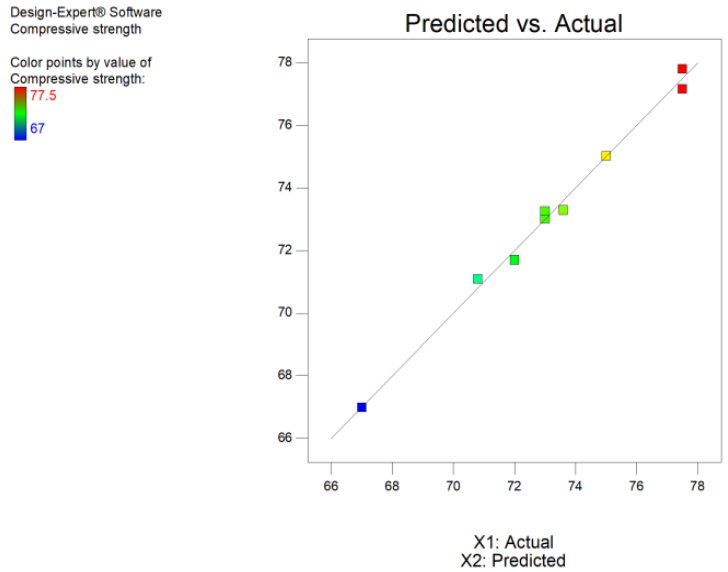
Figure 12. Predicted vs. Actual compressive strength of EGC .